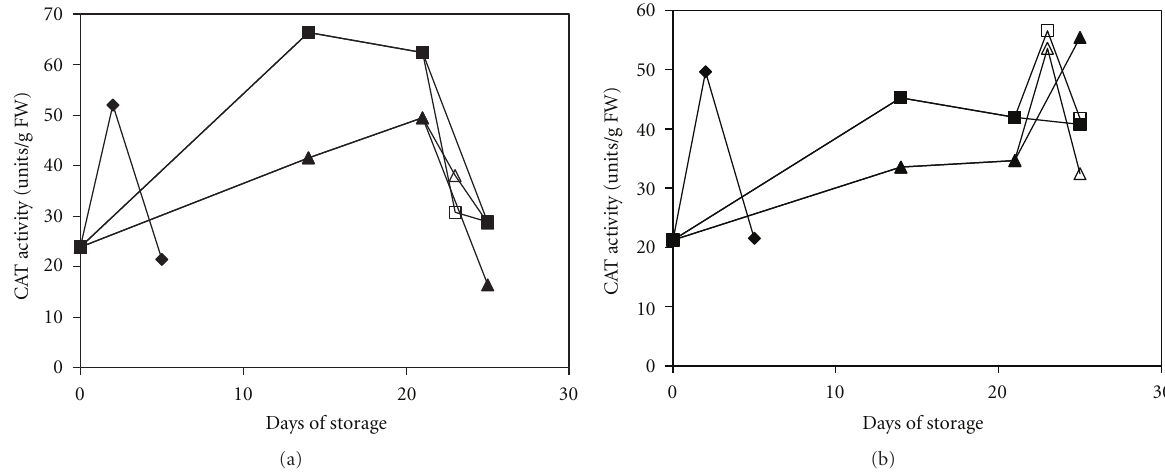
Figure 7: Changes in the CAT activity of mature green peppers (a) and fully ripe/red peppers (b) for the UCRT ( (cid:2) ), MAP ( (cid:3) ), and MAP+1- MCP ( (cid:4) ) treatments during storage at 10 ◦ C; MAP ( (cid:5) ) and MAP+1-MCP ( (cid:6) ) values for the fruits transferred to room temperature at day 21. The values are the means of six replicate samples, and their S.E.s are